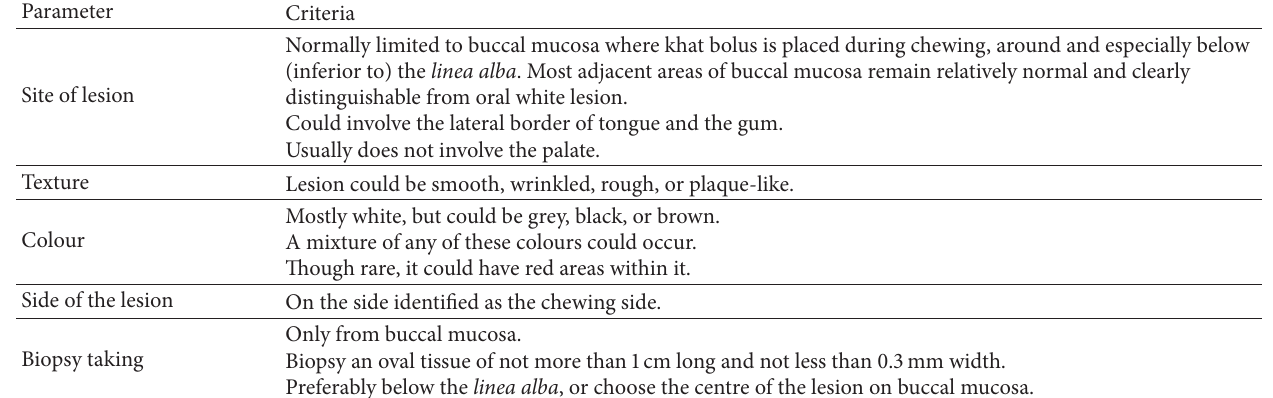
Table 1: Standardized criteria used to identify and to take biopsy of khat induced oral